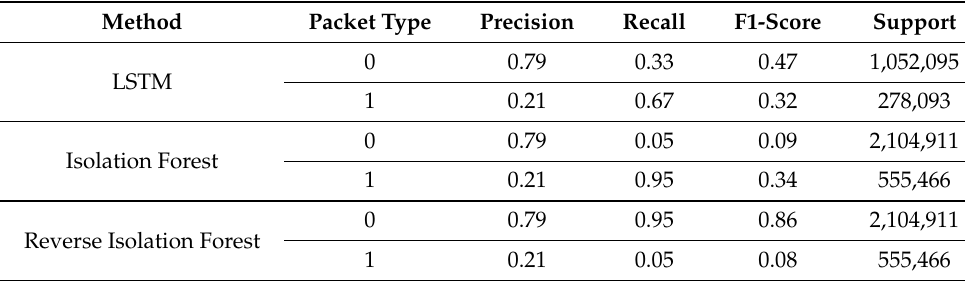
Table 4. The models’ metrics after validation for the CIC-IDS2017